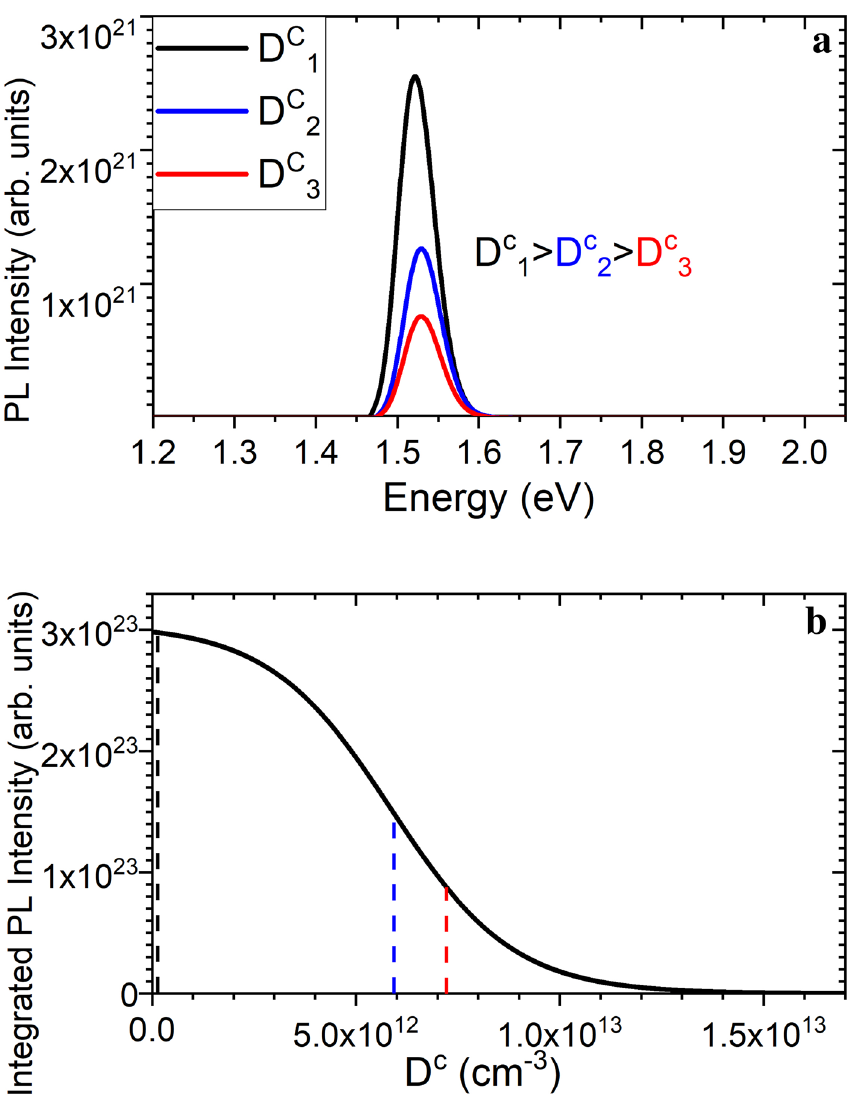
Figure 7. PL spectra calculated for three arbitrary values of D c ( a ) and integrated PL intensity as a function of D c ( b ) (The dashed lines in ( b ) correspond to the spectra in ( a